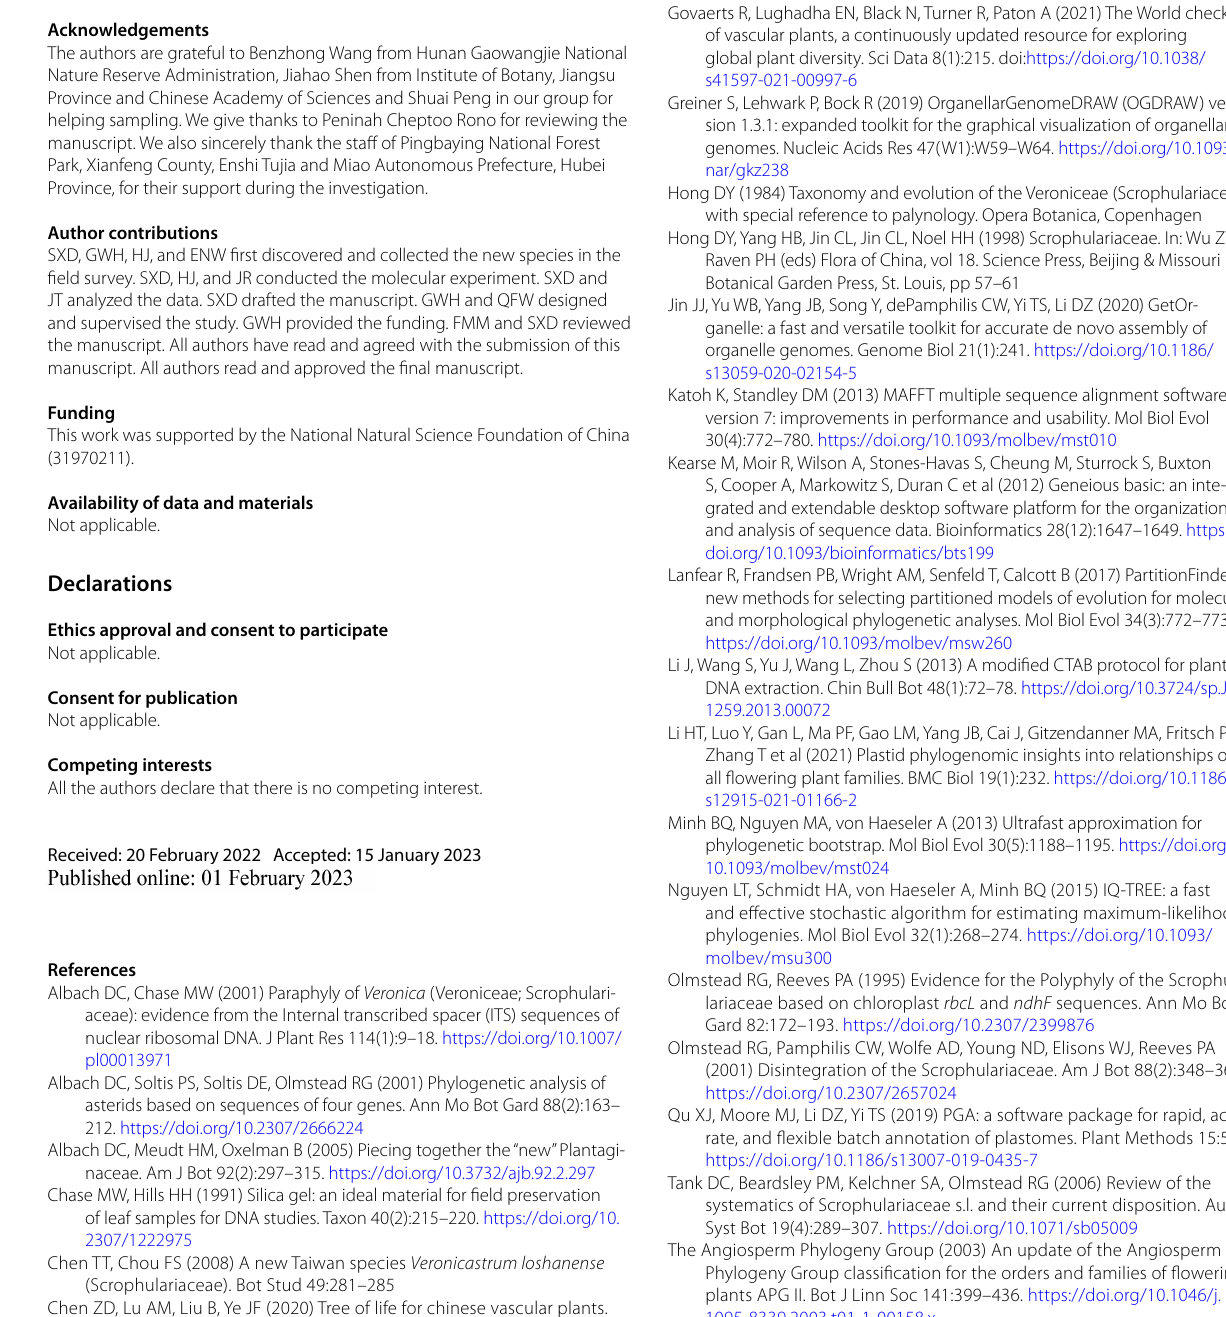
Additional file 1: Table S1. The vouchers of 13 samples of genome skim‑ ming. Table S2. 9 plastid genomesfrom NCBI database. Table S3. 4con‑ catenated sequences based on three DNA plastome fragments from NCBI database. Table S4. 17 concatenatedsequences based on two DNA fragments from NCBI